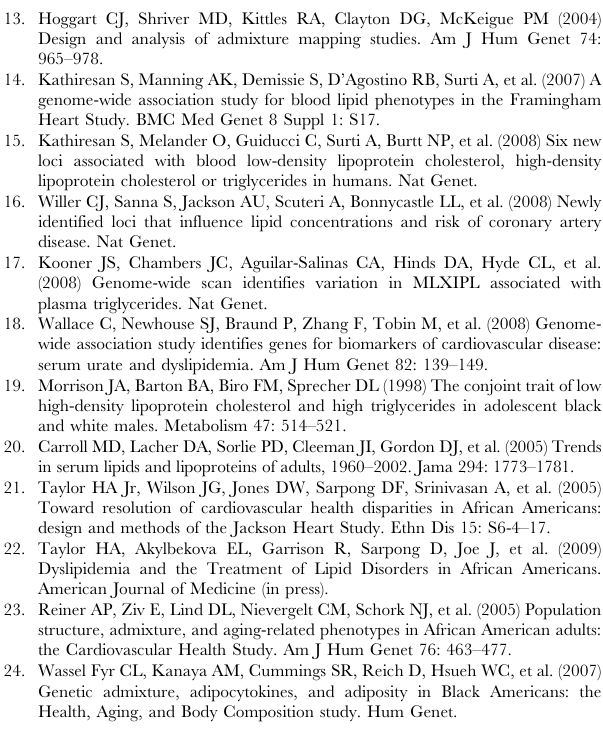
Table S1 Summary of Admixture Scans for Lipid and Cholesterol Traits. For each trait, 4 scans were performed, varying the predictors used in the regression model to select cases and controls, and the method of selecting unrelated individuals. The genome-wide LOD score and top scores for the Cases only and Case-Control statistics are shown. The thresholds of a significant association for the genome-wide and Cases only LOD scores are 2.0 and 5.0, respectively. Table S2 Proportion of genome excluded as contributing to differential risk for triglycerides and cholesterol phenotypes comparing African and European Americans. Table S3 Extent of pairwise linkage disequilibrium measured by r 2 for select SNPs in JHS-AFR-2 LPL and JHS-EUR-2 LPL . Found at: doi:10.1371/journal.pgen.1000342.s004 (0.13 MB Table S4 Effect size of LPL variants on TG levels. P-values for association of TRG with genotype in the total population (p_trg_all) and JHS-AFR-2 LPL (p_trg_afr); SNPs with p , 0.0006 are shown in bold. The p-value for interaction is for the significance of the genotype 6 local ancestry term in the linear regression model for the total population (p , 0.05 is shown in